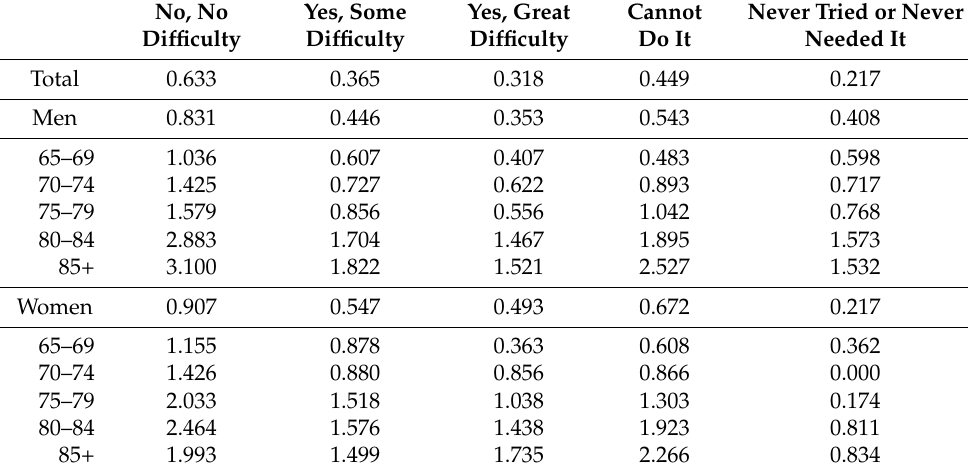
Table A2. Difficulty in making purchases. Sampling errors of row percent by sex and age group.